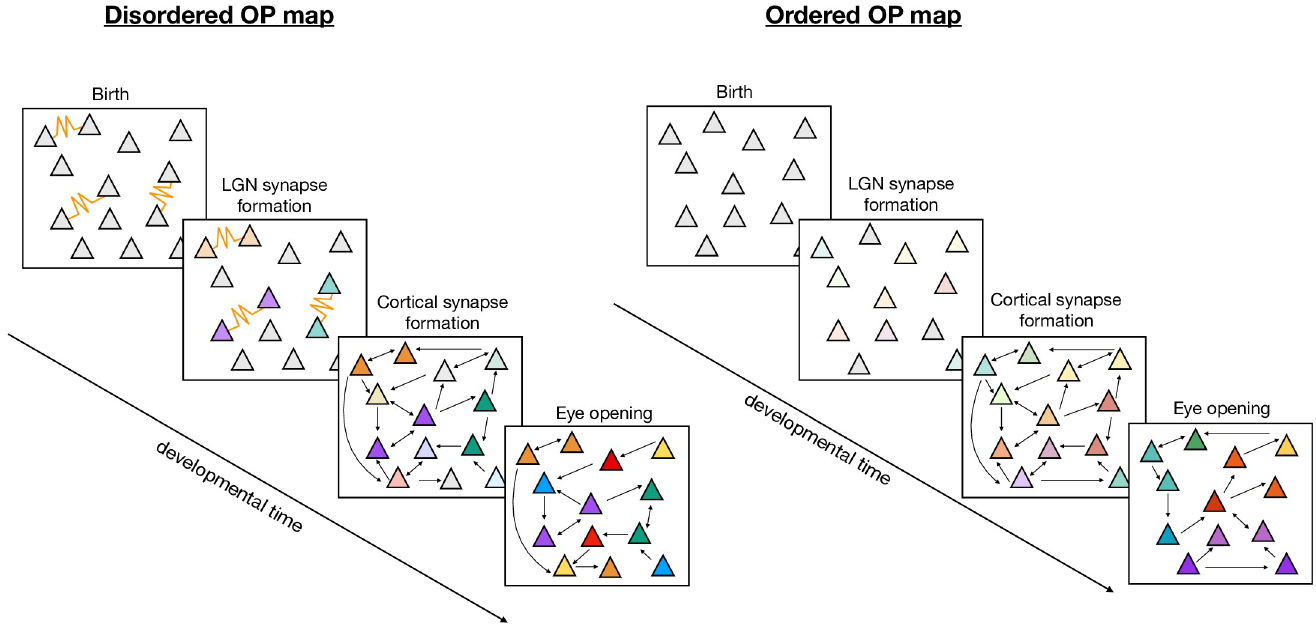
Fig 10. A schematic representing how GJs during the first week might lead to a disordered (i.e., salt-and-pepper) OP map. Each stage drawn here represents: (i) The first postnatal week as labeled by “Birth” and “LGN synapse formation”, (ii) the second postnatal week while chemical synapses are forming, and (iii) the resulting cortical recurrent synapses and OP as indicated by the color of the cell. Transparency represents selectivity, where opaque colors indicate a higher amount of selectivity or sharp tuning.